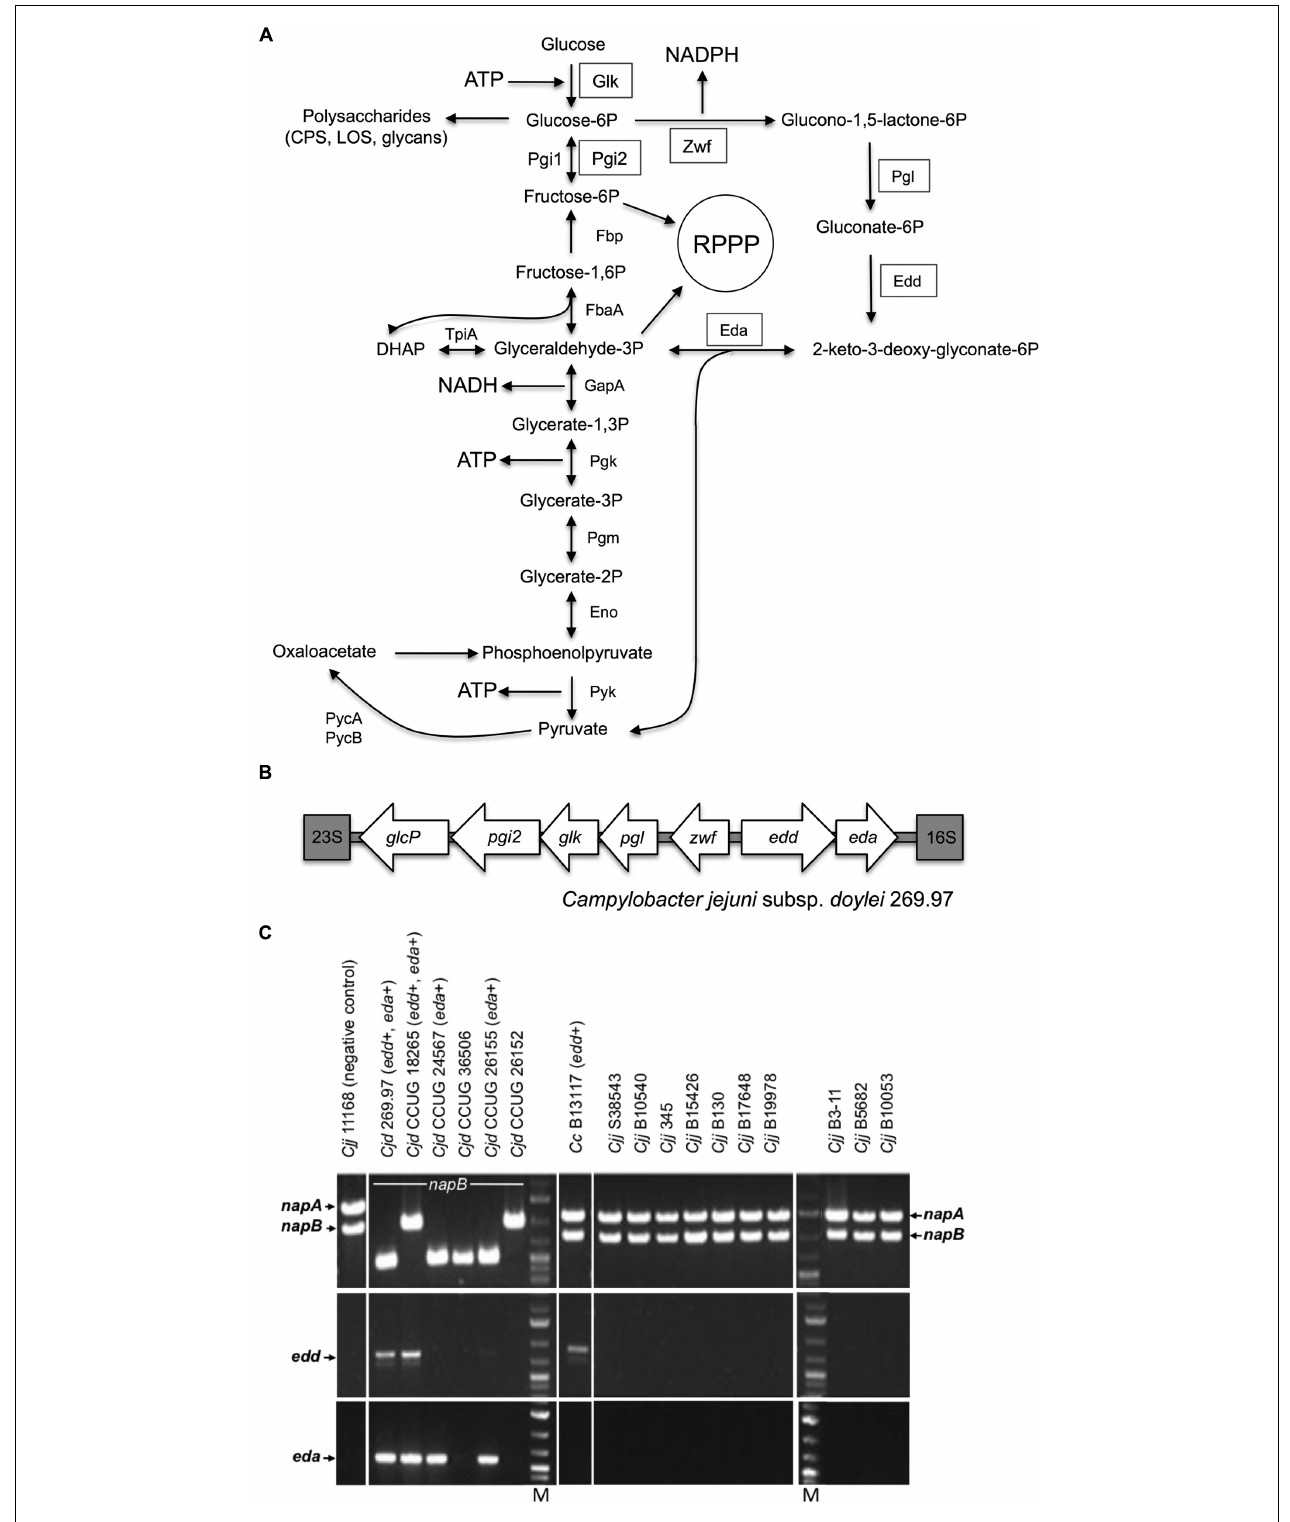
FIGURE 1 | The Entner-Doudoroff pathway in Campylobacter isolates. (A) Scheme of the ED pathway to illustrate how the reactions effectively bypass the lack of phosphofructokinase, which prevents glycolysis by the EMP pathway in Campylobacter , but can also allow cycling of triose-phosphate back to hexose phosphate. The key enzymes 6-phosphogluconate dehydratase (Edd) and 2-keto-3-deoxy-6-phosphogluconate aldolase (Eda) catalyze the dehydration of